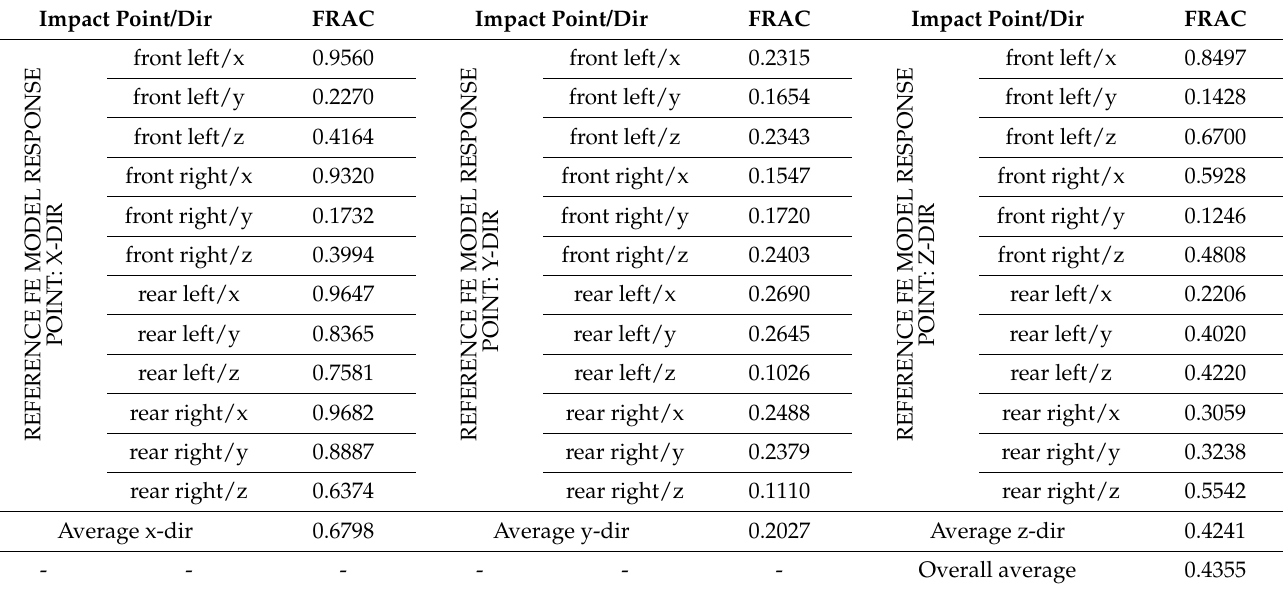
Table 3. FRAC results for the reference FE model of the vehicle body